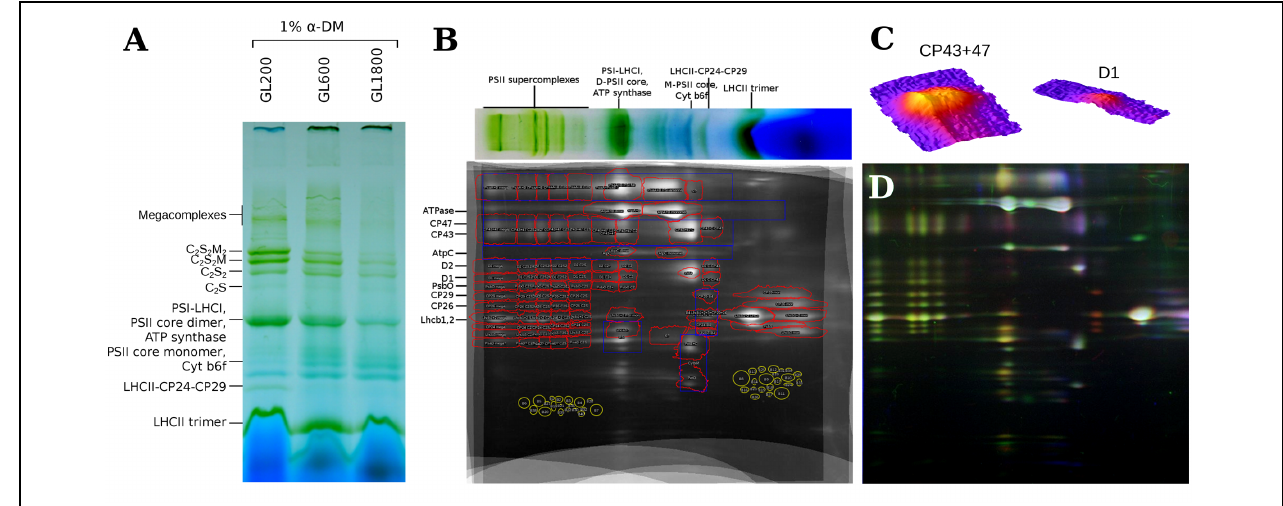
FIGURE 2 | 2D-PAGE of thylakoids isolated from plants grown under different light intensities. (A) The BN-PAGE of thylakoids isolated from plants grown under GL200, 600, and 1800, solubilized with 1% α -DDM. (B) Sum of nine 2D-PAGE gels of isolated thylakoids from plants grown under all light conditions. The red contours represent ROIs of selected proteins in specific complexes. The blue contours represent the integrated areas for quantification of a selected protein independent of the complex. On the top, a lane from the BN-PAGE is shown. (C) Overlap of the gels of thylakoids from plants grown under GL200, 600, and 1800, that are shown in the red, green, and blue channels, respectively. (D) 3D surface plots of CP43 + 47 and D1 megacomplex ROIs,